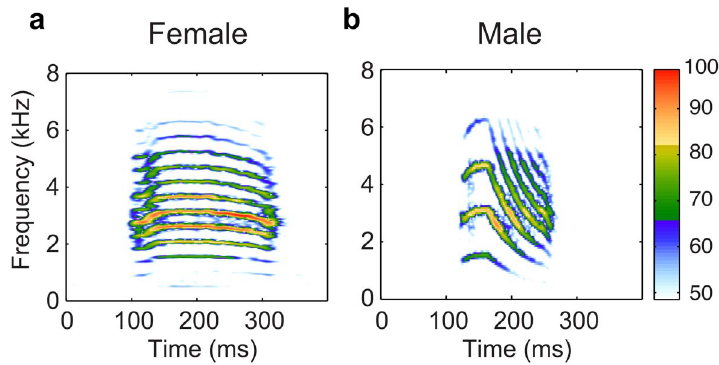
Figure 1. Spectrograms of a female (a) and male (b) distance call, recorded at 2 m. Both signals were high-pass filtered above 500 Hz to avoid displaying low-frequency background noise. The color scale is in relative dB as shown on the color bar with 100 dB corresponding to maximum amplitude observed.